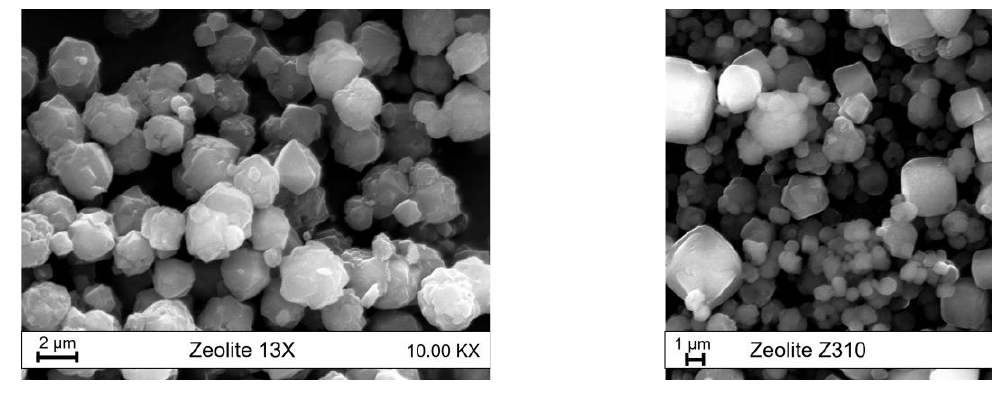
Figure 4. Comparison of FTIR/ATR spectra of the regenerated zeolites 13X and Z310. The zeolite 13X shows one well-defined band at 949 cm −1 , characteristic of the alu- mino-silicate groups that constitute the building structure of zeolites [37]. A more complex peak can be observed for zeolite Z310. In particular, the band at 806 cm −1 belongs to the vibrations of the Si-O bond and the intense bands in the 900–1100 cm −1 region correspond to the stretching vibrations of the Si-O bond (1075 cm −1 ) and Al-O bond (1012 cm −1 ) in the mixed silicon–aluminum–oxygen skeleton [38]. 3.2. Extrusion with Degassing: Optimization of the Process Conditions As reported in the Experimental section (Section 2.2), both the recycled plastics were processed with degassing at two different residence times: LRT = 40 s and HRT = 120 s. Moreover, samples with higher water content (PW_H and Fil-S_H) were also extruded with the purpose of evaluating the effect of water as a stripping agent on the deodorization effectiveness of degassing. In Figure 5a,b, the panel tests’ results are reported in terms of Average Odor Intensity (AOI) for the specimens based on PW and Fil-S, respectively. 700900110013001500